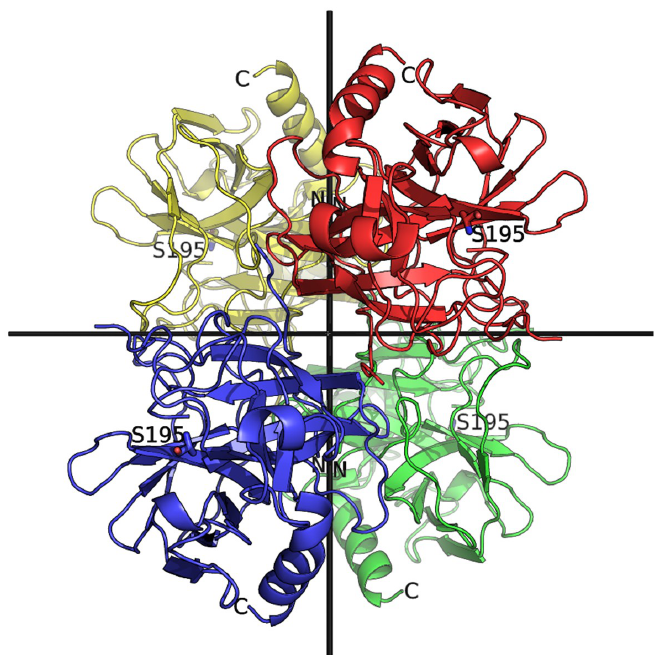
Figure 2. Asymmetric unit of bovine α-chymotrypsin crystallized in space group P6 5 (PDB ID: 6DI8). The four chymotrypsin molecules are coloured differently and shown in cartoon representation. The view is down one axis of two-fold non-crystallographic symmetry; the other two perpendicular axes are shown as black bars. The nucleophilic serines (Ser195) at the catalytic site are shown as sticks. N- and C-termini are labelled. Table 5. Crystallographic interfaces for unliganded α -chymotrypsin in space group P6 5